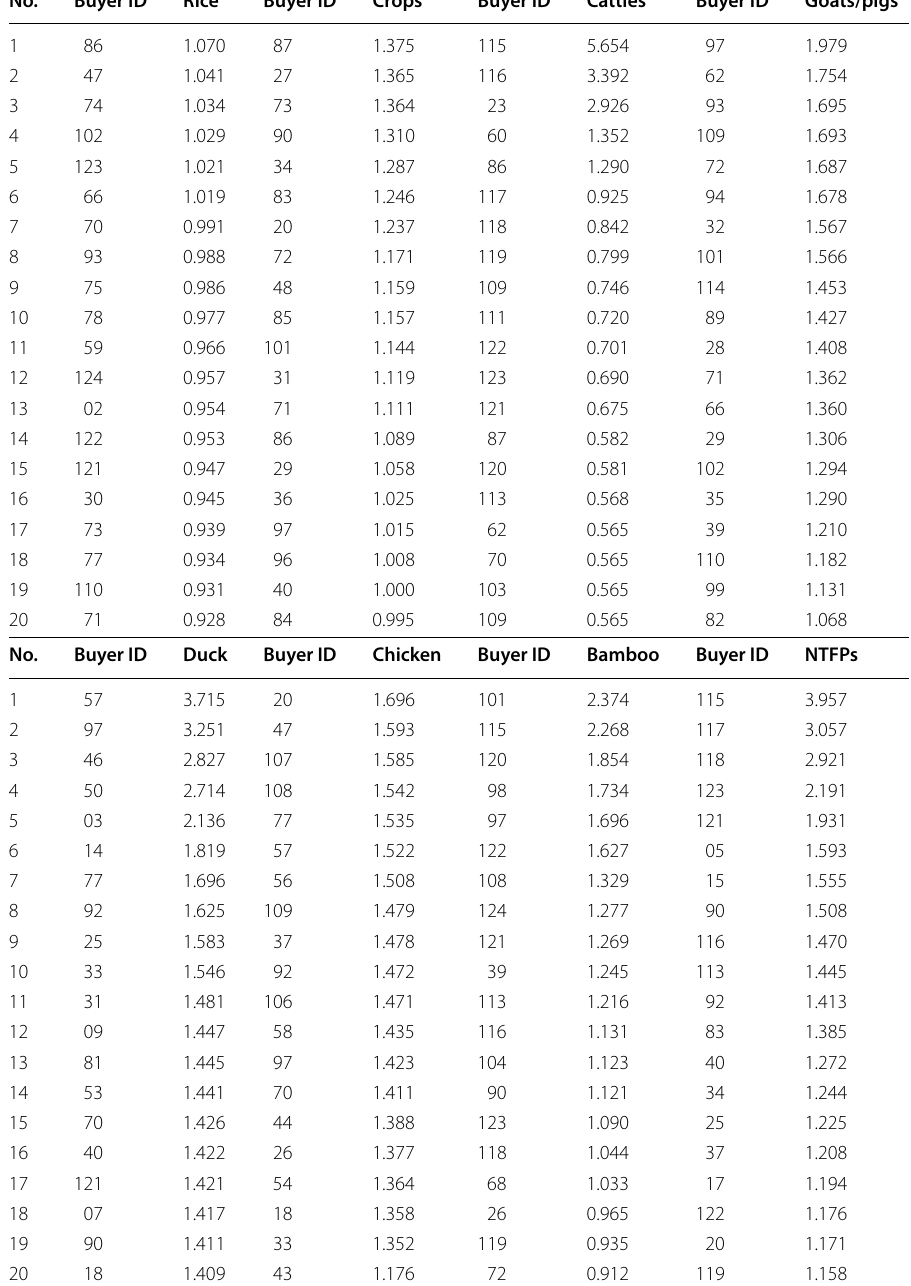
Table 12 Backward linkage values for major product transactions (indices). Source: author’s calculation from VIOT (March 8,